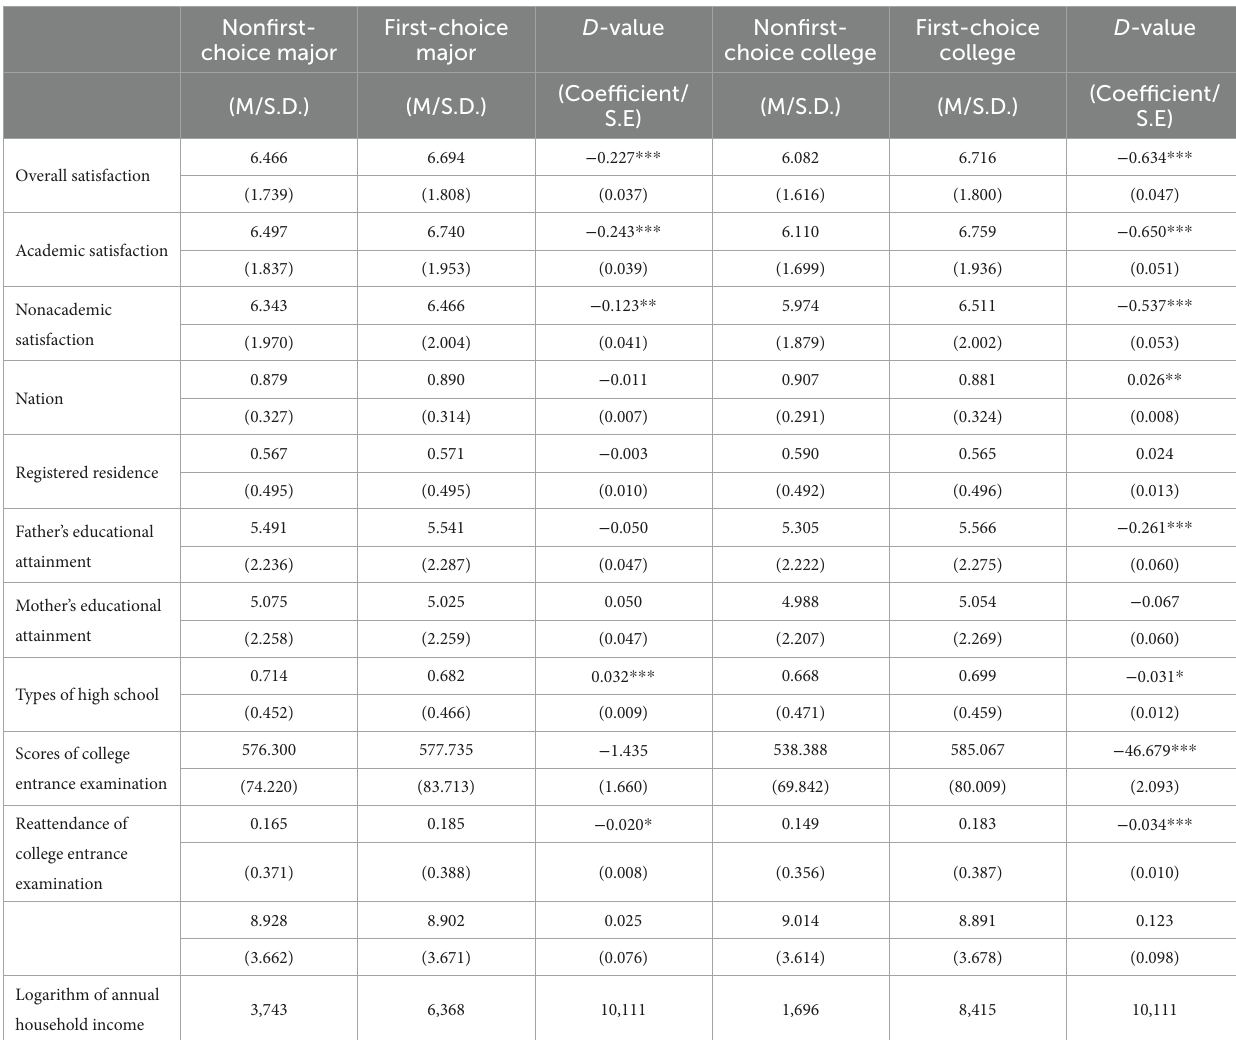
TABLE 4 Differences in characteristics between first-choice students and nonfirst-choice